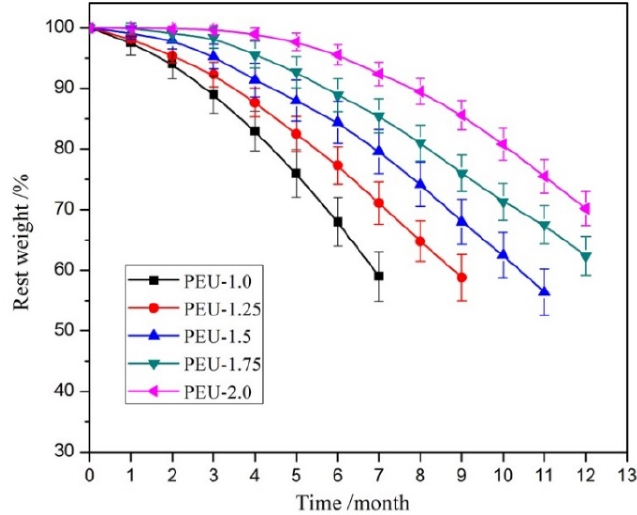
Figure 8. Weight-loss for PEU films as function of breakdown duration within PBS (pH: 7.4) at 37 ◦ C